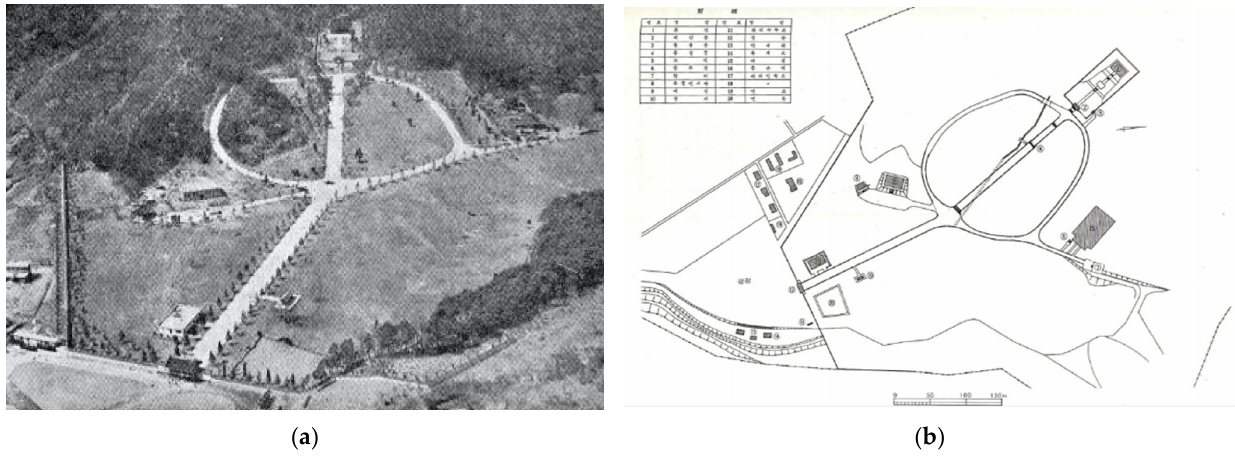
Figure 3. Panoramic View of Hyeonchungsa before its Reconstruction Project in 1966 (Source: Cul- tural Heritage Administration).